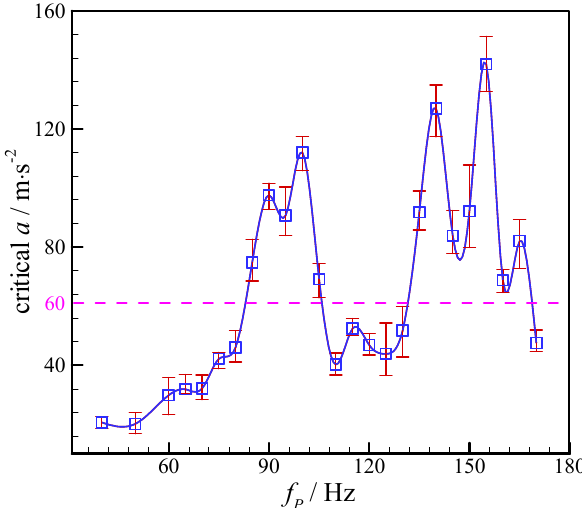
Figure 8. Variation of critical amplitude with external vibration frequency. ( Q c = 90 μ L/h and Q d = 60 μ L/h.).